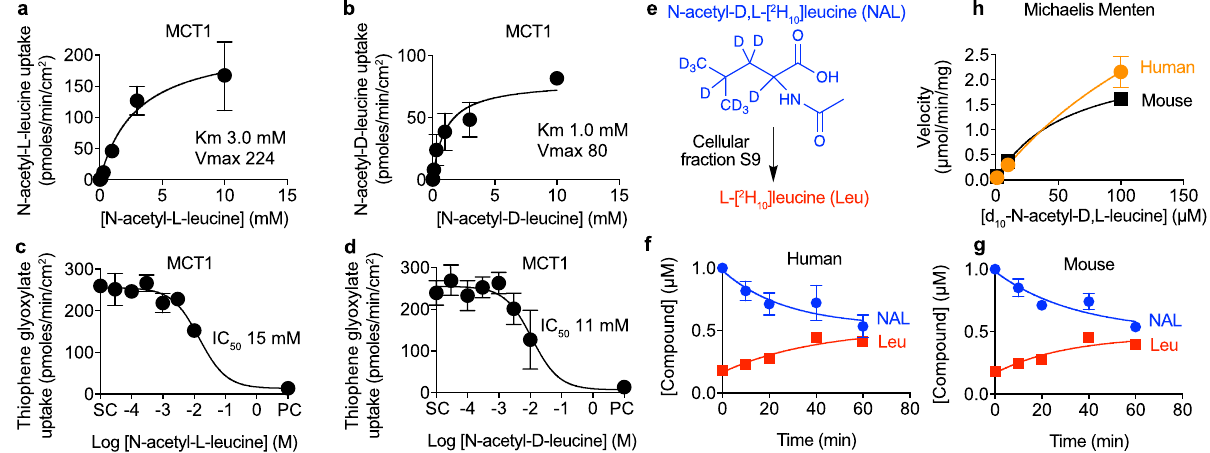
Figure 4. Both enantiomers of N -acetyl-leucine are transported by the monocarboxylate transporter (MCT1) but only the l-enantiomer is metabolized. Concentration–response curves for the uptake of ( a ) N -acetyl-l- leucine and ( b ) N -acetyl-d-leucine. Concentration-inhibition curves for the inhibition of uptake of the known substrate ( c , d ) 2-thiophene glyoxylate (500 µM). DMSO (0.5%) was the solvent control (SC) and the known inhibitor phloretin (500 µM) was the positive control (PC). ( e ) Chemical structure of deuterated N -acetyl-d,l- leucine incubated with cellular fraction S9 from liver to determine metabolism using liquid chromatography and mass spectrometry. ( f , g ) Time courses for loss of deuterated N -acetyl-d,l-leucine (1 µM initial concentration) and appearance of deuterated L-leucine for extracts derived from human and mouse livers. Data are colour- coded according to the chemical structures and names shown in e with deuterated N -acetyl-d,l-leucine in blue and deuterated l-leucine in red. ( h ) Concentration versus initial velocities relationship for metabolism yielded a K m values of 216 and 69 µM and Vmax values of 6.8 and 2.6 µmol/min/mg protein for human and mouse, respectively. Data were fit to the Michalis–Menten equation for transporter uptake and metabolism or the Hill equation for transporter inhibition using the solvent control to define the top and the positive control inhibitor to define the bottom. Symbols represent the mean ± SEM, n = 3. When the error bars are smaller than the symbol, they are not